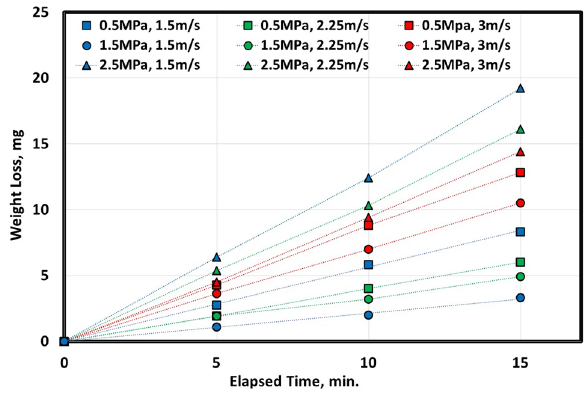
Figure 1. Variation of weight loss with different sliding speeds of 0.16C hot rolled